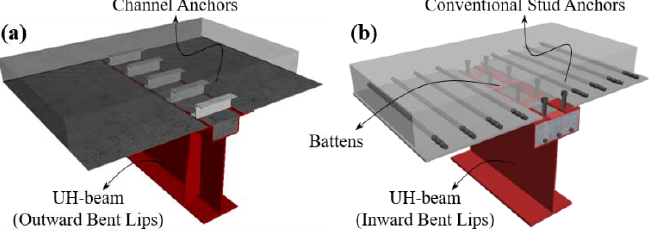
Figure 1. Application of steel anchors to UH-beams: ( a ) UH-beam with Z-channel anchors; ( b ) UH-beam with conventional stud anchors.